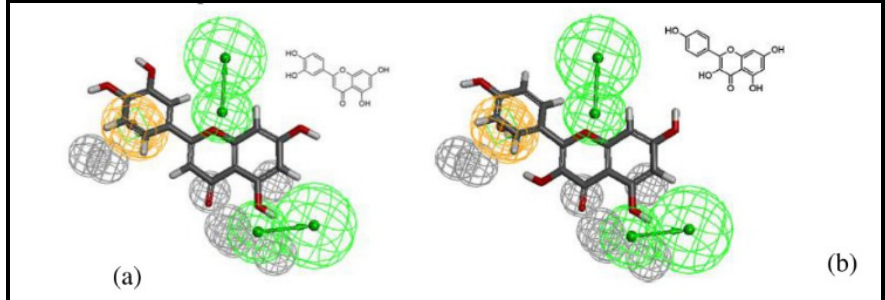
Figure 7. A mapped pharmacophore model of ( a ) luteolin-7-glucoside (aglycone) and ( b ) kaempferol [60,61].